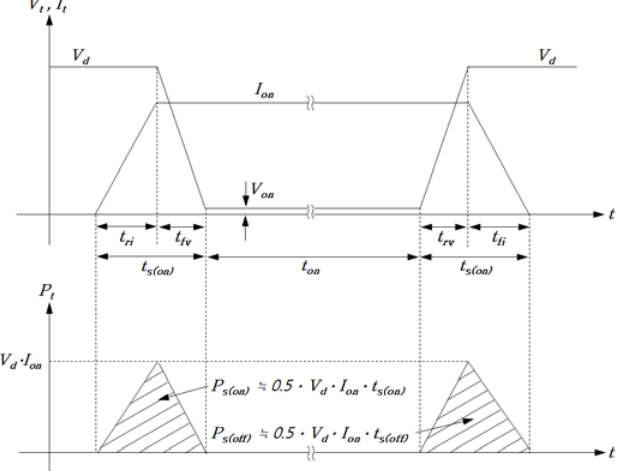
Figure 5. Linearized waveform of voltage and current